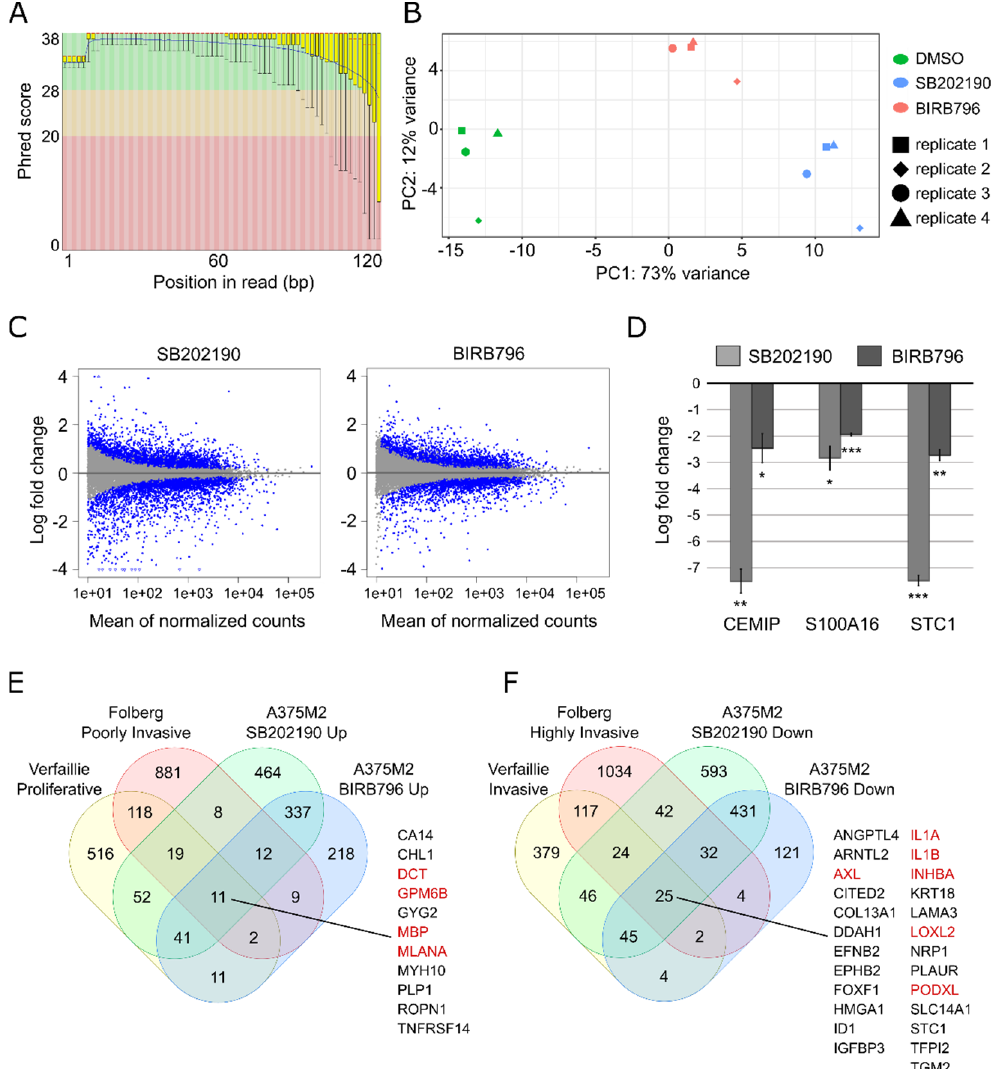
Figure 4. Technical validation of RNA sequencing results. ( A ) Per base sequence quality of RNA sequencing reads expressed as Phred score by position, sample 1, first reads. ( B ) Principal component analysis of gene expression profiles. ( C ) MA plot of log2 fold change values against normalised counts for each gene in the analysis. Blue points mark genes with FDR<0.1. ( D ) Log2 fold change values of the indicated genes detected by RT-qPCR in three samples independent from the RNA-seq series. Error bars: standard deviation. Adjusted p -values: *** p < 0.001, ** p < 0.01, * p < 0.05. ( E , F ) Venn diagrams representing intersections of gene lists from the indicated datasets. Highlighted in red are the genes whose higher expression is well known to be characteristic of either the differentiated/proliferative ( E ) or of the dedifferentiated/invasive phenotype ( F ).